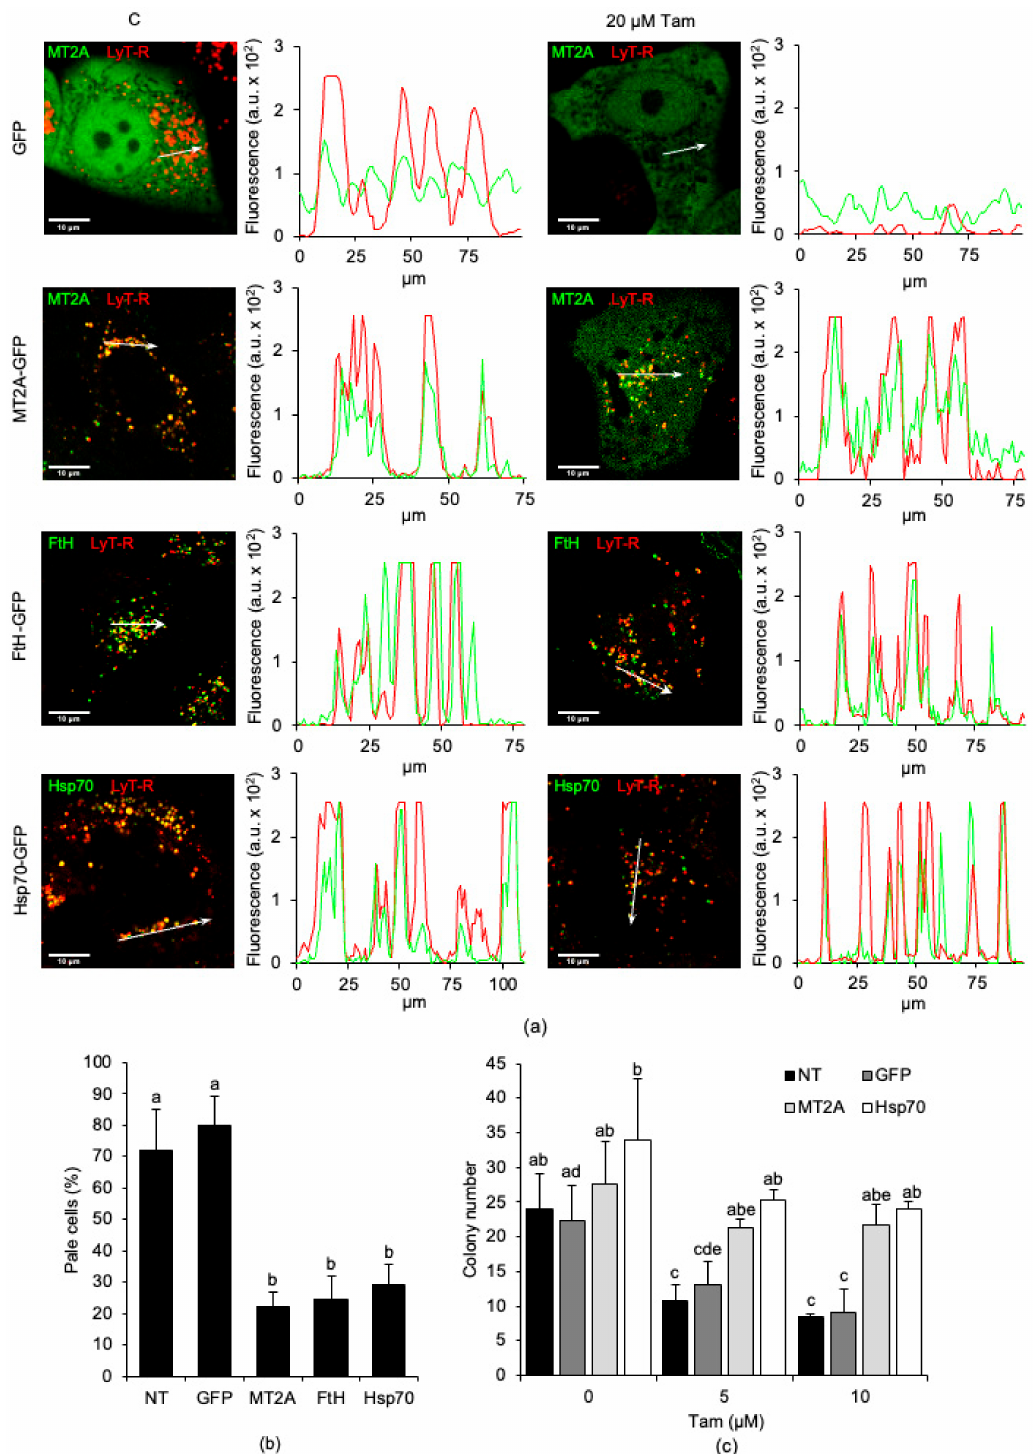
Figure 6. Overexpression and lysosomal relocation of MT2A, FtH, or Hsp70 abrogate Tam-induced LMP and elicit Tam resistance in MCF7 parental cells. ( a ) Lysosomal relocation of GFP, MT2A-GFP, FtH-GFP, or Hsp70-GFP (from first to fourth row, respectively). Images are representative of at least three independent transfections. Intensity plots (arbitrary intensity units) of red and green fluorescence of the organelles encompassed by the white arrow. ( b ) Attenuation of LMP induced by 20 µ M Tam for 2 h in MCF7 parental cells non-transfected or overexpressing GFP, MT2A, FtH, or Hsp70. LMP was evaluated only in GFP-expressing cells, counted in three to five microscopic fields from three independent transfections. ( c ) Clonogenic potential of MCF7 cells non-transfected or stably transfected with GFP, MT2A, or Hsp70 and exposed to 5 or 10 µ M Tam for 24 h. NT: non-transfected parental cells. For panels ( b , c ), data and statistical analysis are as in Figure